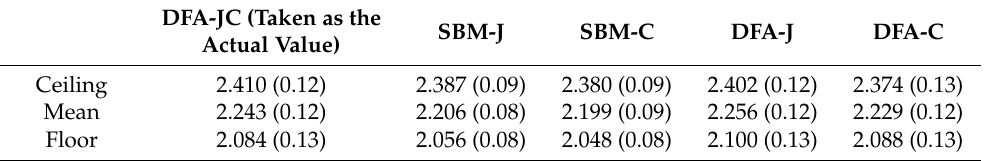
Table 2. Means and standard deviations (in parentheses) of F0 range parameters (in the logarithmic scale) estimated from the Japanese-Chinese parallel speech corpus. SBM-J and SBM-C represent the results of the refined spectrum-based model estimated from the 20 Japanese utterances and from the 20 Chinese utterances, respectively. DFA-J and DFA-C indicate the results of direct F0 analysis from the Japanese and Chinese utterances, respectively, while DFA-JC indicates the result of direct F0 analysis from all 40 utterances, which is here regarded as the actual value of the underlying F0 range. DFA-JC (Taken as the SBM-J SBM-C DFA-J DFA-C Actual Value) Ceiling 2.410 (0.12) 2.387 (0.09) 2.380 (0.09) 2.402 (0.12) 2.374 (0.13) Mean 2.243 (0.12) 2.206 (0.08) 2.199 (0.09) 2.256 (0.12) 2.229 (0.12) Floor 2.084 (0.13) 2.056 (0.08) 2.048 (0.08) 2.100 (0.13) 2.088